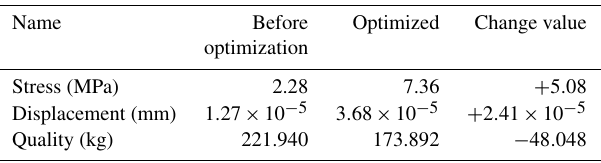
Table 5. Optimized first six modes of the bone-filled